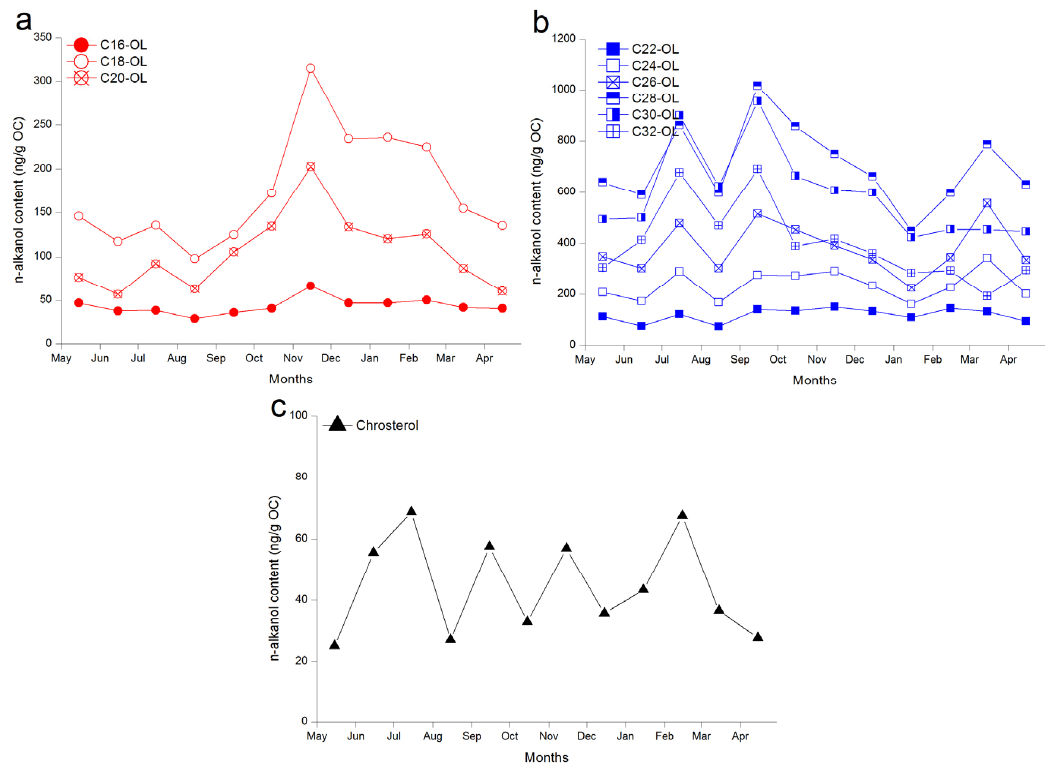
Figure 11. Temporal variations in individual alkanol TOC normalized contents of ambient air aerosols in south coastal Xiamen. ( a ) short-chain n -alkanols; ( b ) long-chain n -alkanols; and ( c ) cholesterols.